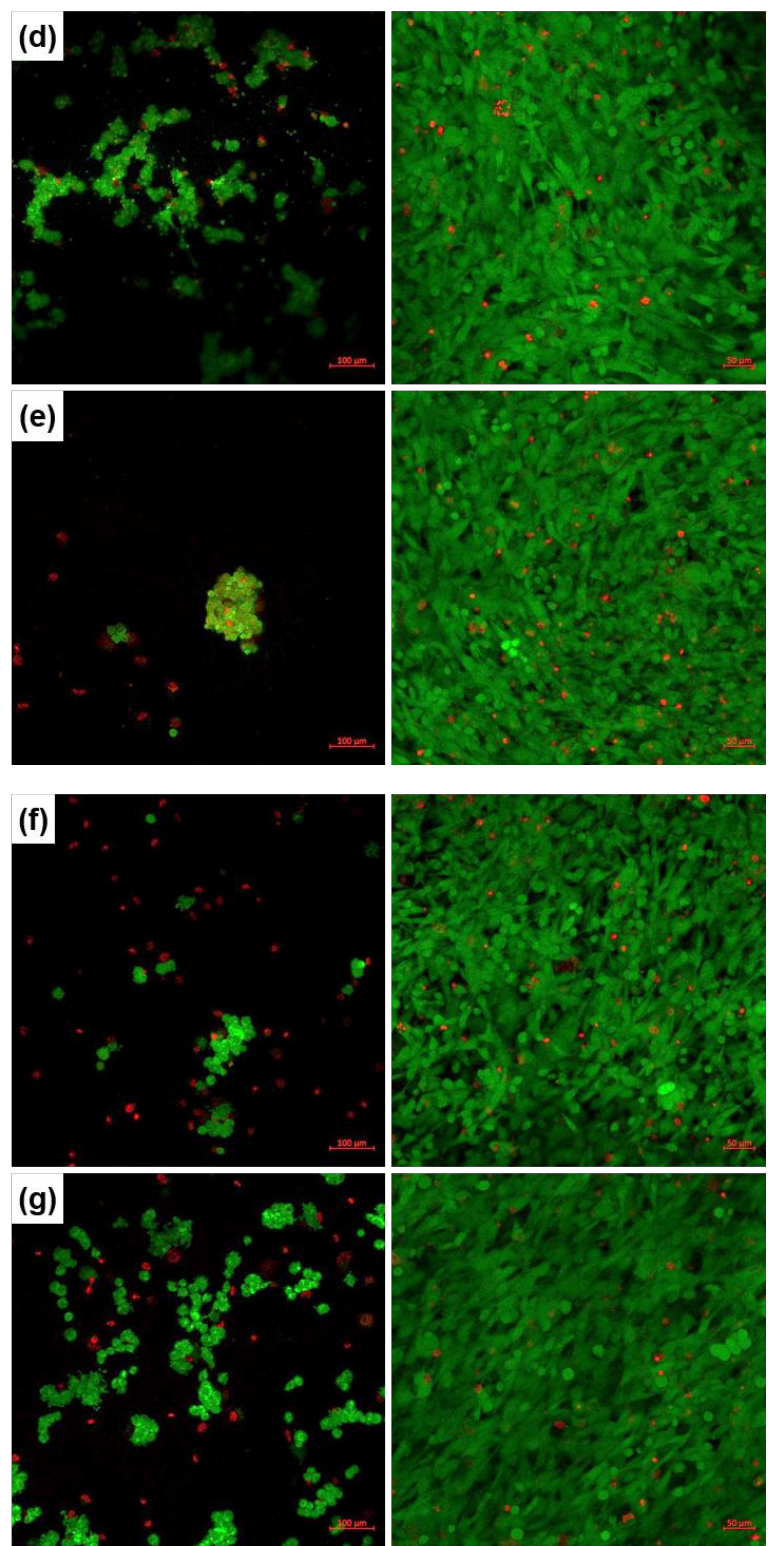
Figure 6. Fluorescence images recorded on human fetal osteoblasts, cultured for 1 ( left ) or 4 days ( right ), on: ( a ) Control, ( b ) PLD-Mg-1, ( c ) PLD-Mg-2, ( d ) PLD-Sr-1, ( e ) PLD-Sr-2, ( f ) SC-Mg and ( g ) SC-Sr